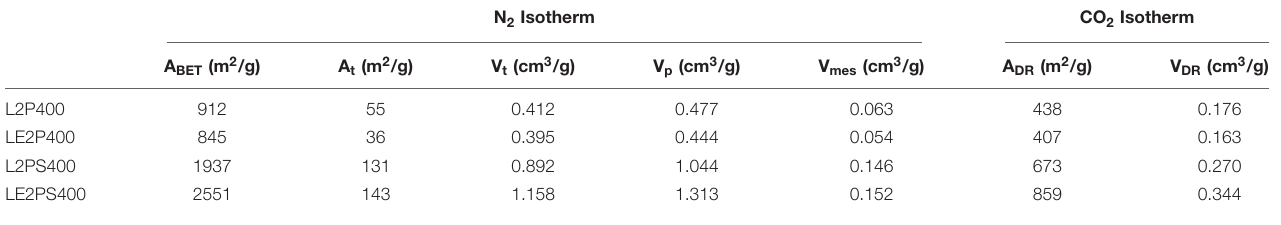
TABLE 3 | Textural properties of the different lignin derived activated carbons obtained from the N 2 and CO 2 isotherms. N 2